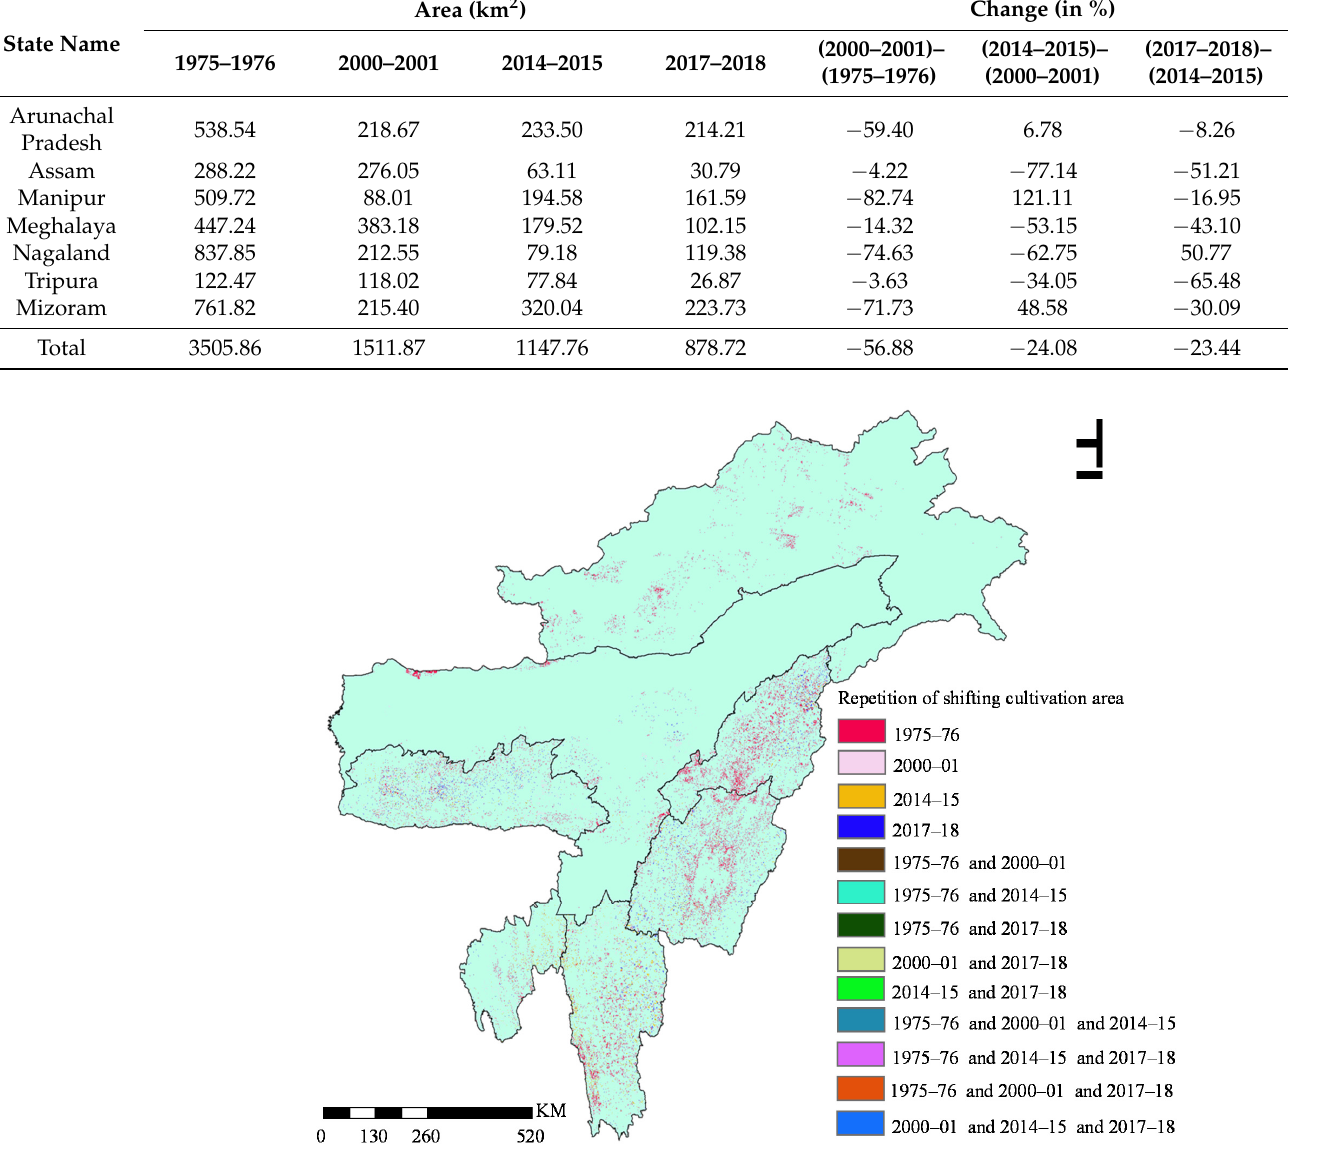
Figure 7. Repetition map of shifting Cultivation areas demonstrated that overall there is higher alternation of shifting cultivation patches than repetition during the period of 1975 to 2018.